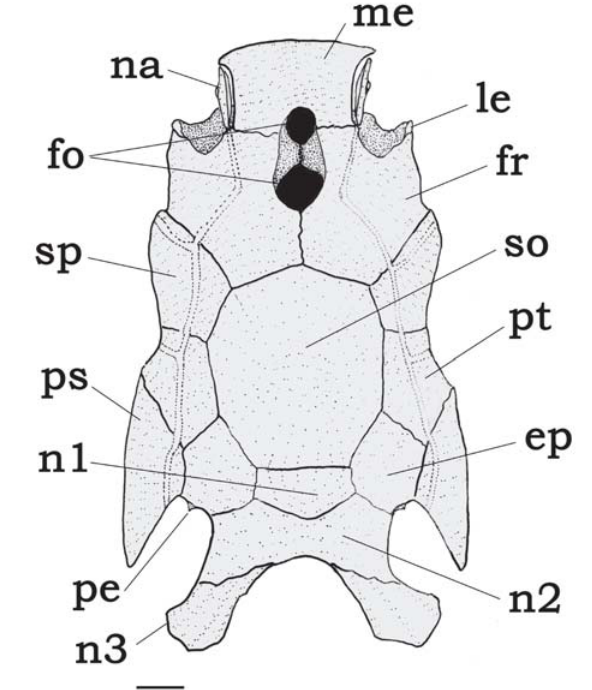
Fig. 31. Neurocranium of Tatia meesi , new species,